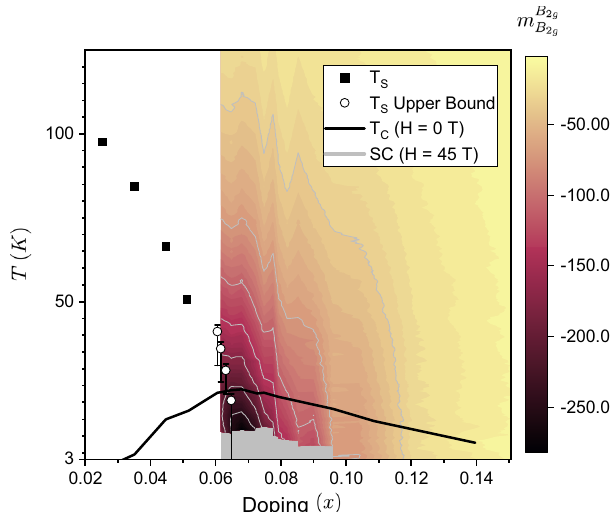
Fig. 2 Phase diagram of Ba(Fe 1 − x Co x ) 2 As 2 overlaid with the doping dependence of m B 2 g for compositions with x ≥ 0.0616 (color plot). The B 2 g black line is the zero- fi eld superconducting transition and the gray region is the 45 T superconducting dome. The far underdoped structural transition temperatures (black squares) and zero- fi eld superconducting transition temperatures are from J.-H. Chu et al. 27 . The white circles represent the onset of the structural transition taken from resistivity measurements at 45 T (see Supplementary Fig. 2 and Supplementary Note 2). Critical temperatures for the magnetic phase transition are not Fig. 1 The doping and temperature dependence of m B 2 g . a Temperature B 2 g dependence of m B 2 g for the composition closest to x c , B 2 g Ba(Fe 0.932 Co 0.068 ) 2 As 2 , in fi elds of 11.4 and 45 T. Inset shows the absence of any observable fi eld dependence of m B 2 g above the zero- fi eld B 2 g superconducting transition. b The evolution of m B 2 g with doping as a B 2 g function of temperature. Data taken with fi elds between 0 and 45 T.